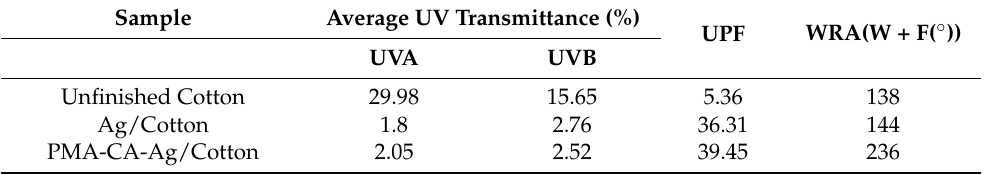
Table 1. UV and wrinkle resistance of the Unfinished Cotton, Ag/Cotton and